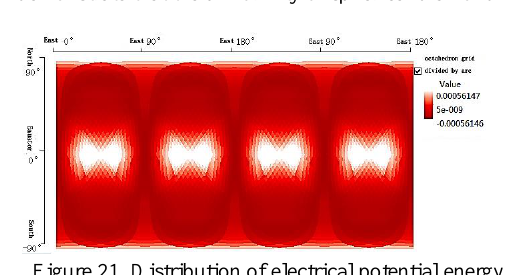
Figure 21. Distribution of electrical potential energy of spherical diamond discrete grids octahedron grid divided by arc